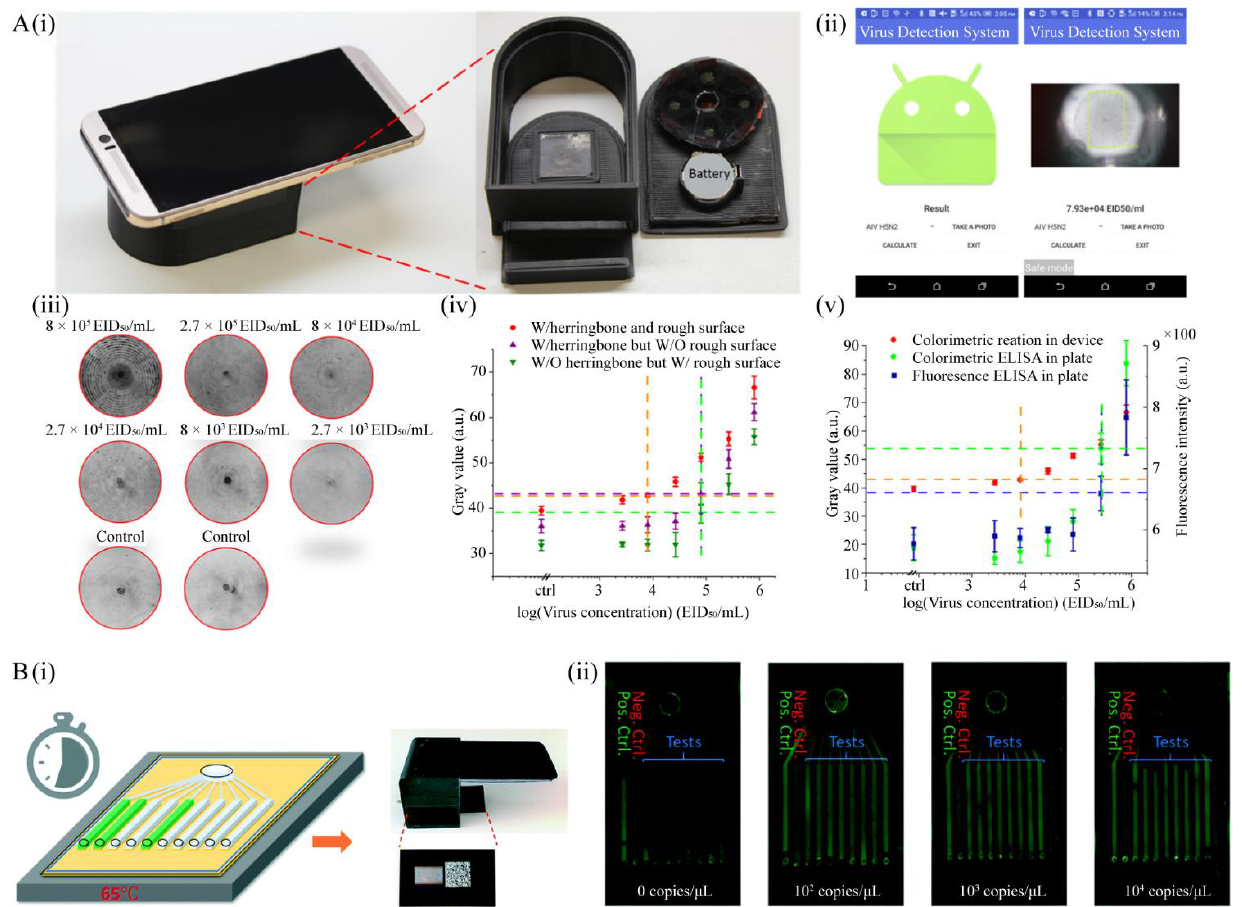
Figure 5. Smartphone-based POC platforms for respiratory virus detection. ( A ) ( i ) Photograph of the smartphone-based on-chip system; ( ii ) smartphone application interface; ( iii ) graphs of AIV virus detection with the smartphone-based on-chip detection system; ( iv ) comparison of with/without the herringbone structure and ZnO nanorod replication virus detection; ( v ) comparison of the colorimetric detection system and conventional ELISA assay in virus detection (reproduced with [58]. Copyright 2019, American Chemical Society). ( B ) ( i ) The chip is heated at 65 °C for LAMP reactions and inserted into the cradle for end-point fluorescence imaging; ( ii ) fluorescence image of EHV1 templates at different concentrations (reproduced with [59]. Copyright 2020, Royal Society of Chemistry).